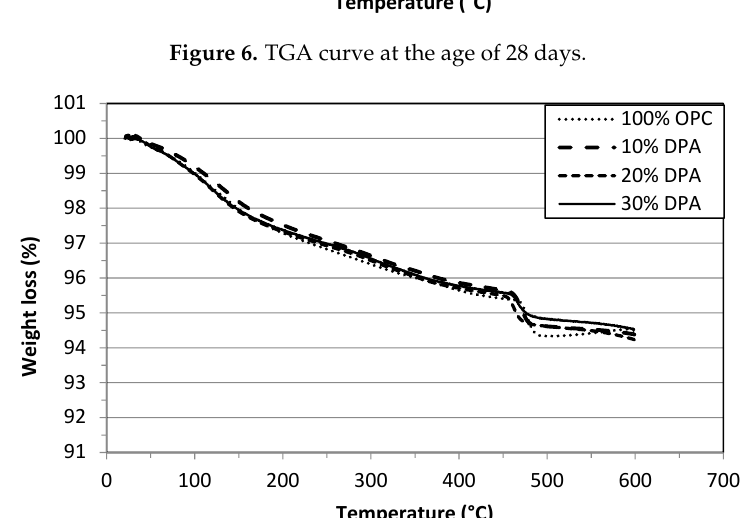
Figure 7. TGA curve at the age of 360 days.